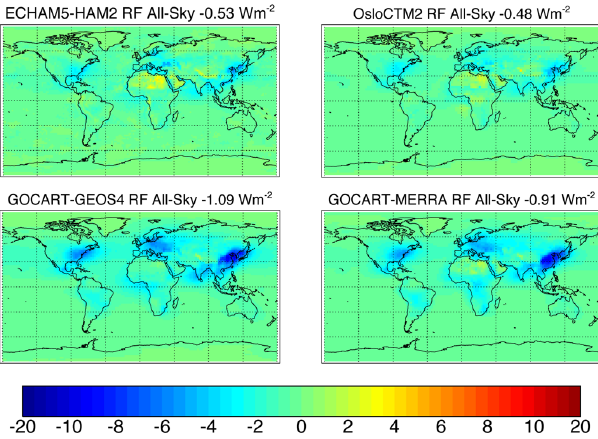
Fig. 22. Annual mean short-wave all-sky top-of-atmosphere radia- tive forcing (RF) between present day and pre-industrial experi- ments with identical aerosol radiative properties based on an early release of Kinne et al.